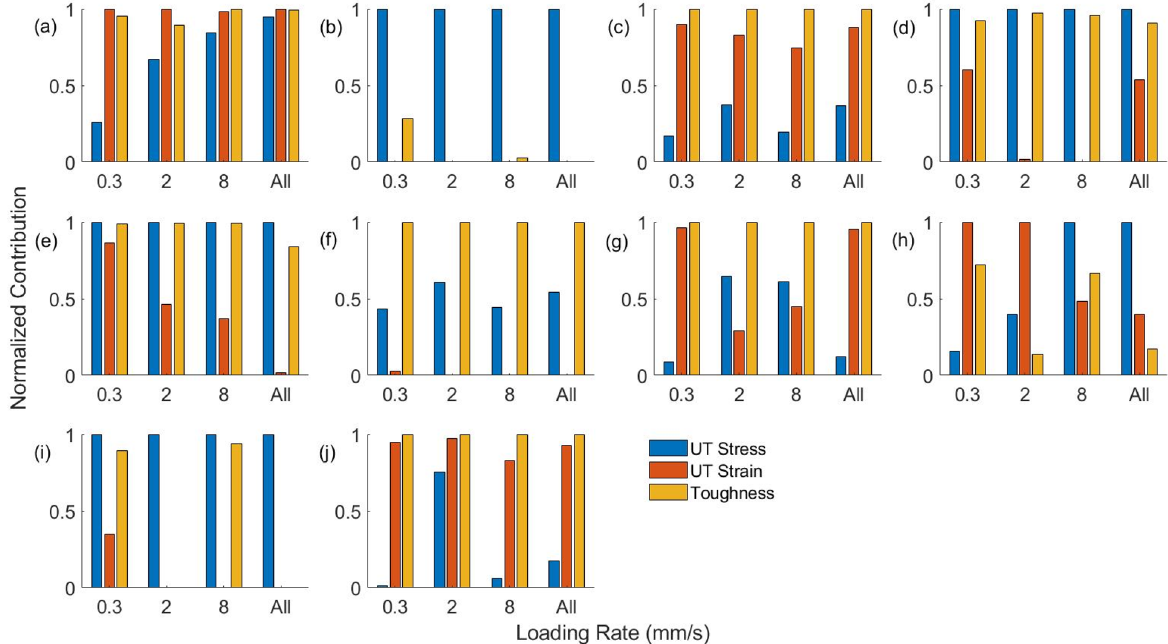
Figure 4. Contribution of each of the three material properties in the binary classification of full thickness burned porcine skin tissue and each of the 10 synthetic tissues (( a )–( j ): tissue groups 1–10) using samples loaded at each of the three loading rates and all samples